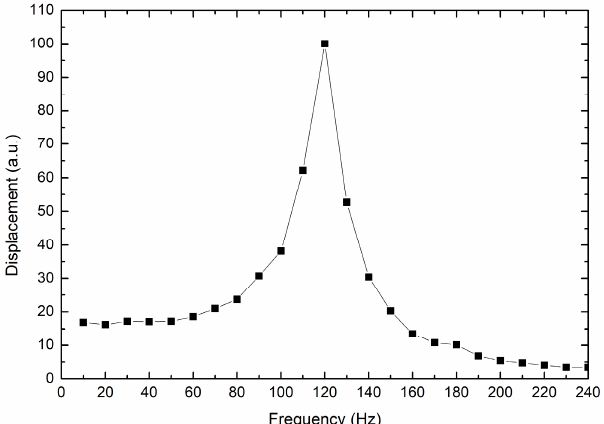
Figure 11. Displacement of the piezoelectric actuator when a frequency-varying sinusoidal signal with 20 V pp is applied.